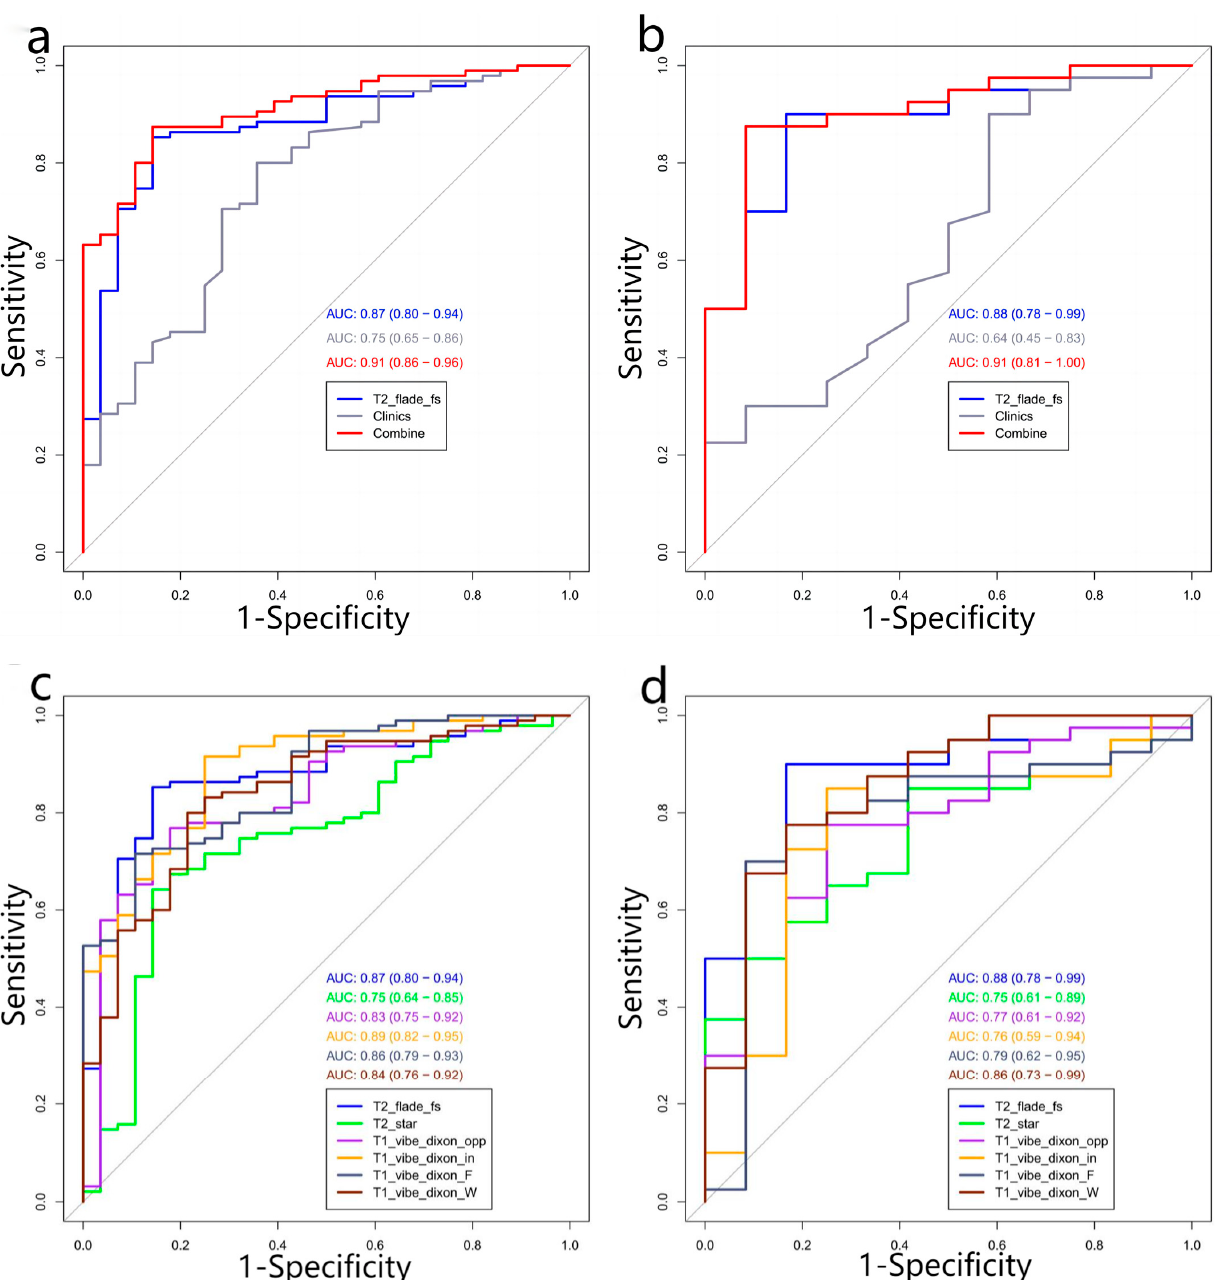
Figure 2. ( a , b ) ROC curves of α - and β -genotyping of thalassemia patients in the T2 model, clinical model, and joint model. ( c , d ) ROC curves of each radiomics model. Note—T2 flade fs = T2 fblade fs/T2 ssfse tra bh. Table 4. Predictive efficacy of radiomics model, clinical model, and combined model.